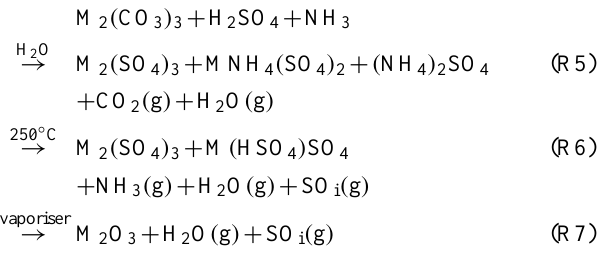
Fig. 7. Intensity of the fragments HSO + ( m/z = 81) and H 2 SO + ( m/z = 98) normalised to the intensity of the fragment SO + 3 4 the FROST2 campaign. On the horizontal axis, the first line now shows the thermodenuder temperature in contrast to Fig. 1, the second one indicates if the water bath was used, the third one if ammonium was added. The “lr” marked in the special line refers to an experiment with an additional residence volume of 10l after the particle coating. The last line refers to the temperature of the sulphuric acid coating